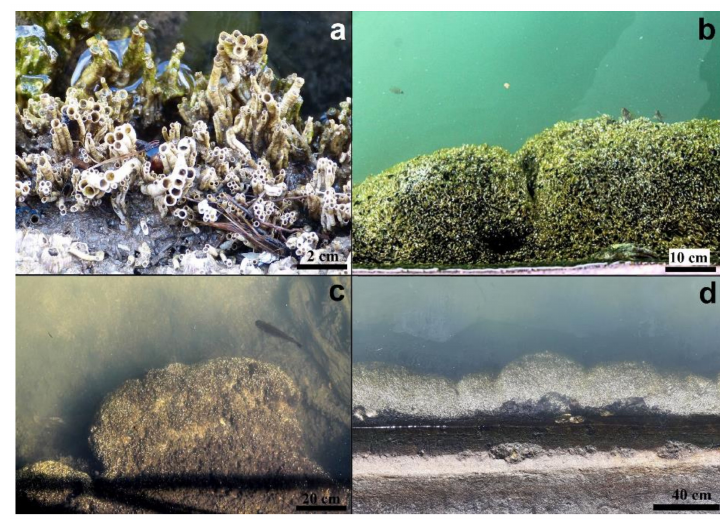
Figure 1. Ficopomatus reef at Fiumicino, Rome (Italy): calcareous tubes cemented one to another ( a ); details of the bioconstruction, forming belts that fringe the shoreline in a continuous layer up to 0.5 m thick, showed at progressively increased distances ( b – d ). Photo credit: A. Bonifazi.